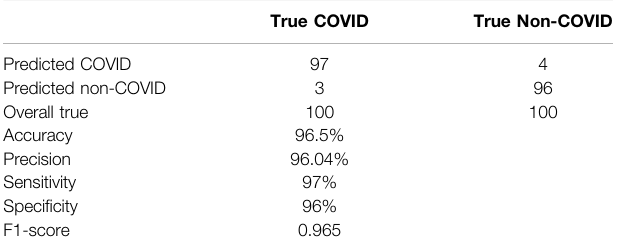
TABLE 3 | Testing results of ResNet50